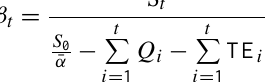
Fig. 8. Correlation between ∆S/∆TS and α in the Spoon River watershed.